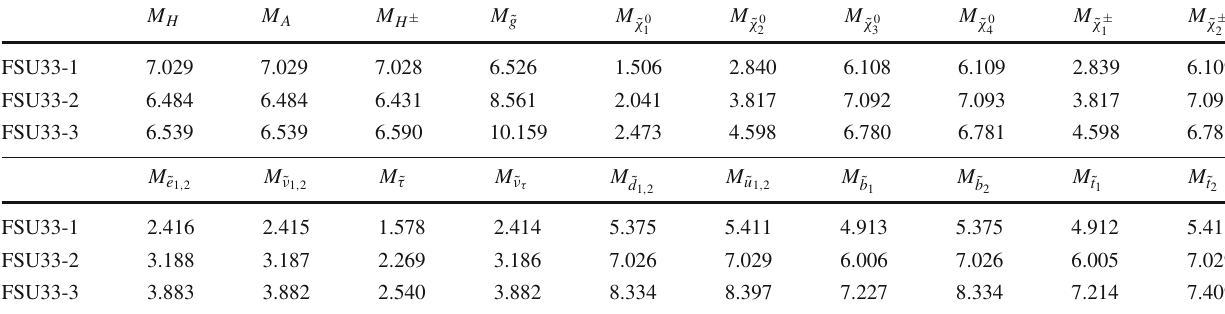
Table 8 Masses for each benchmark of the finite N = 1 SU ( 3 ) 3 (in